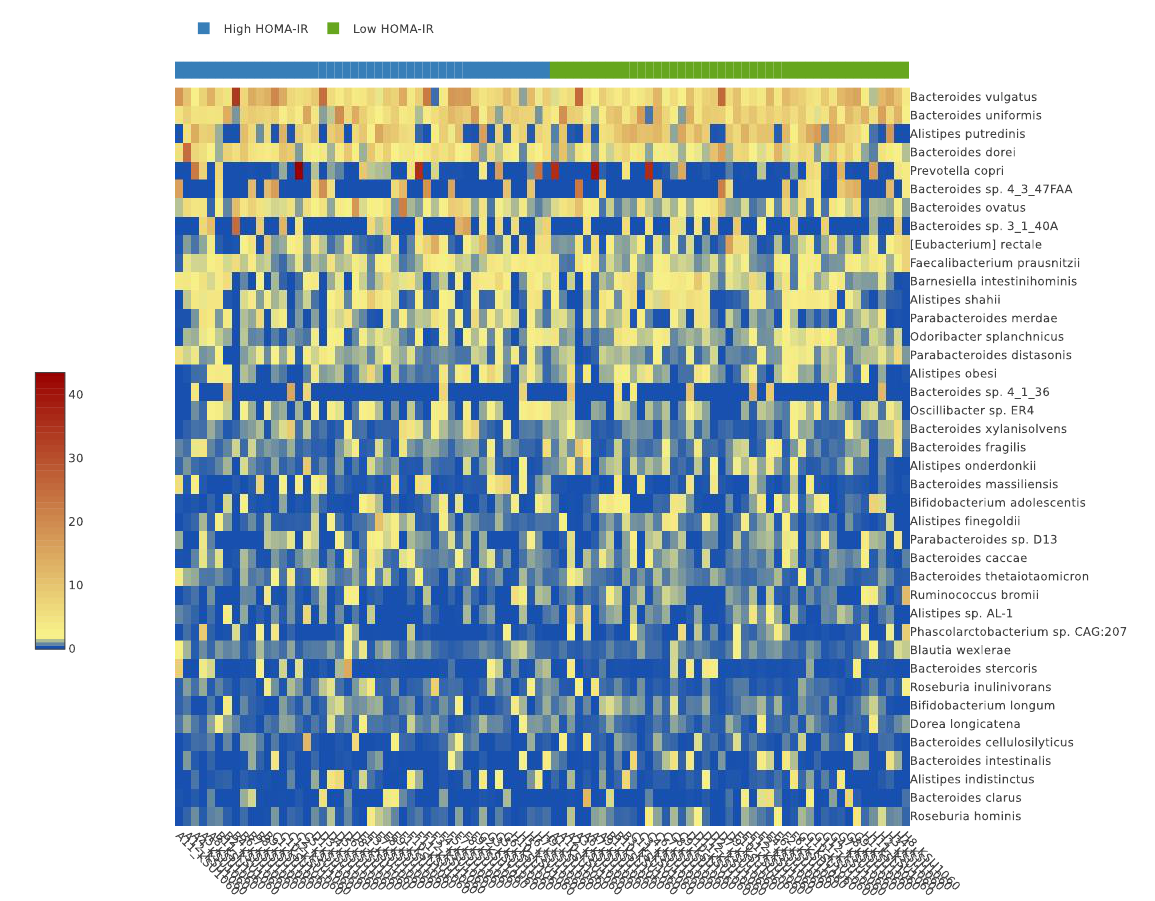
Figure 1. The heatmap analysis of the participants with high and low HOMA-IR. Table 1. Characteristics of participants stratified by HOMA-IR, n = 92